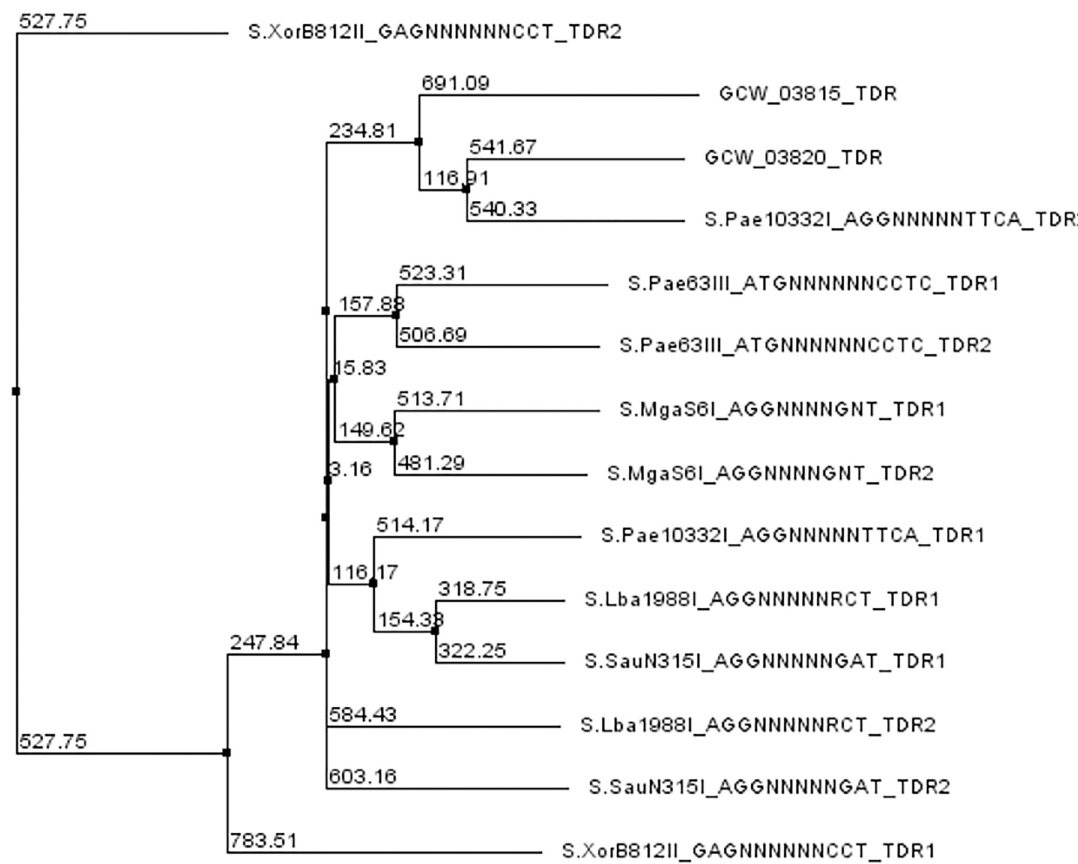
Fig 4. Phylogenetic tree of TRDs of specificity subunits of M . gallisepticum S6 and other TRDs with similar specificity. The names in the leaves represent the TRD names, which consist of the REBASE name of the HsdS and its sequence specificity. The numbers on the nodes are distance measures calculated using BLOSUM62 substitution